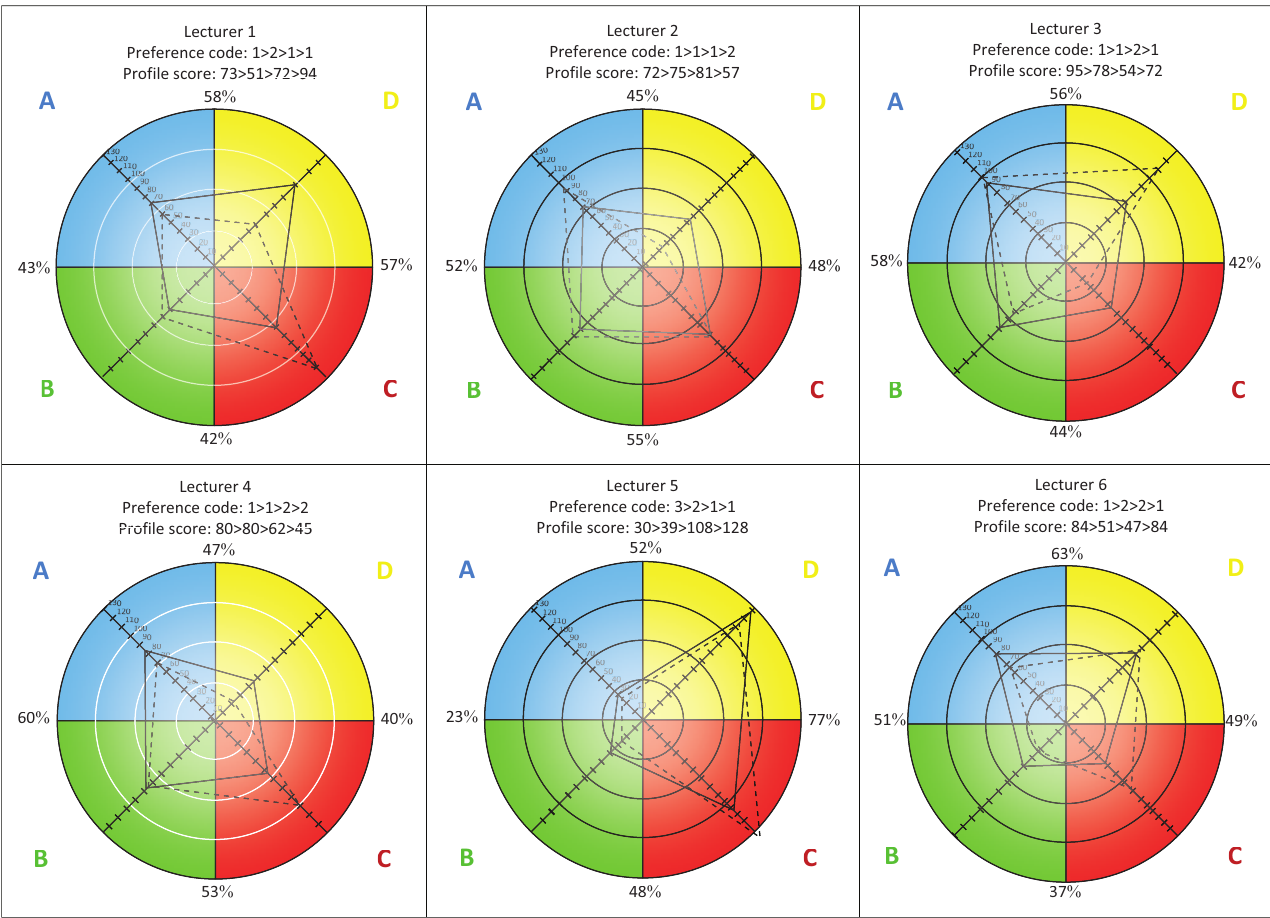
FIGURE 4: Thinking preference profiles of members of the scholarly community of practice.